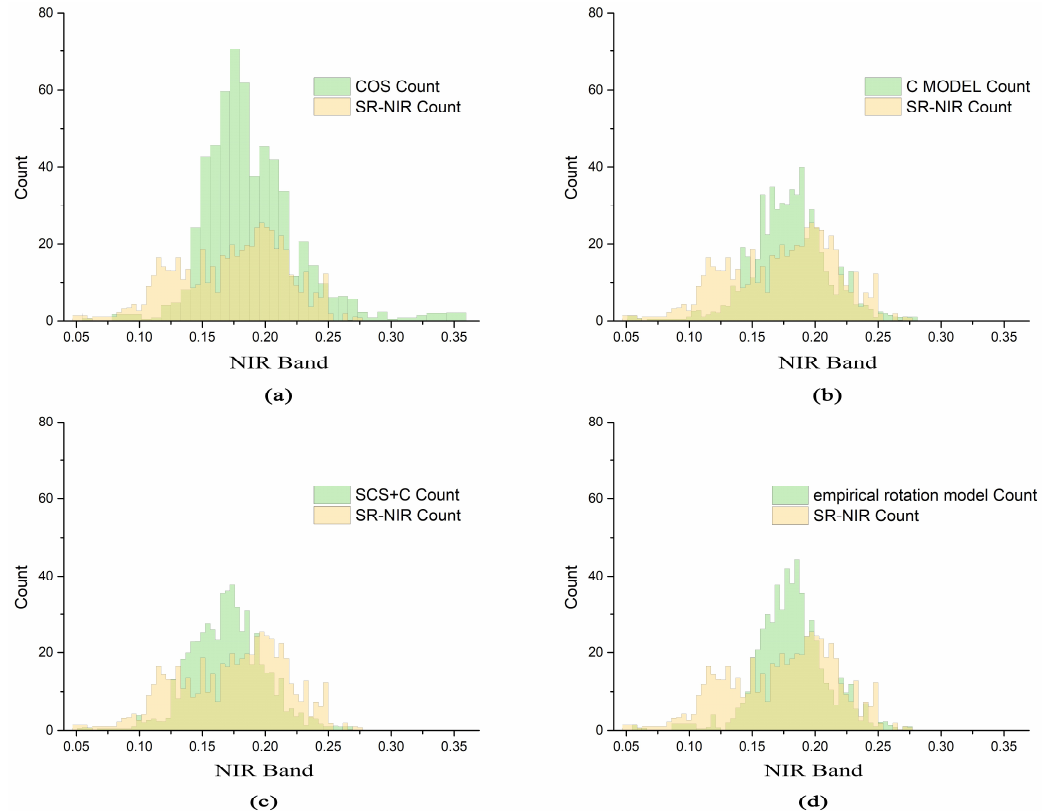
Figure 4. Frequency histograms before and after topographic correction in the NIR band by four models. Surface reflectance (SR)-NIR represents the precorrected conditions of the NIR band. The topographic correction model by using ( a ) the cosine model, ( b ) C model, ( c ) SCS + C model and ( d ) empirical rotation model.